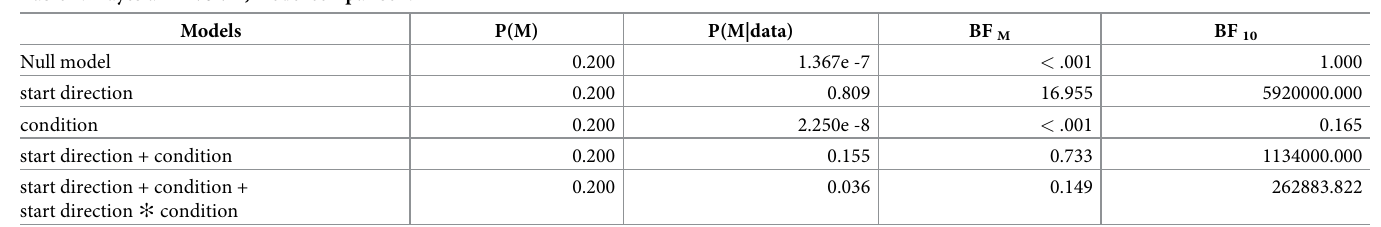
Table 2. Bayesian ANOVA, model comparison.